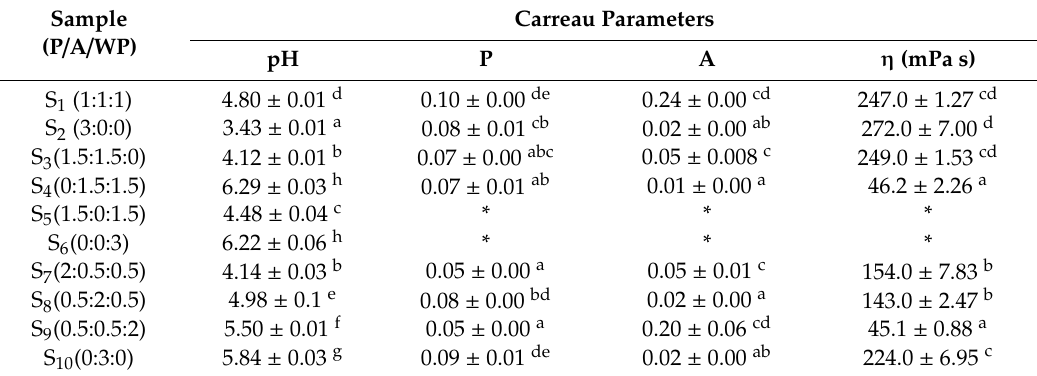
Table 3. Physico-chemical and rheological properties of the edible coating